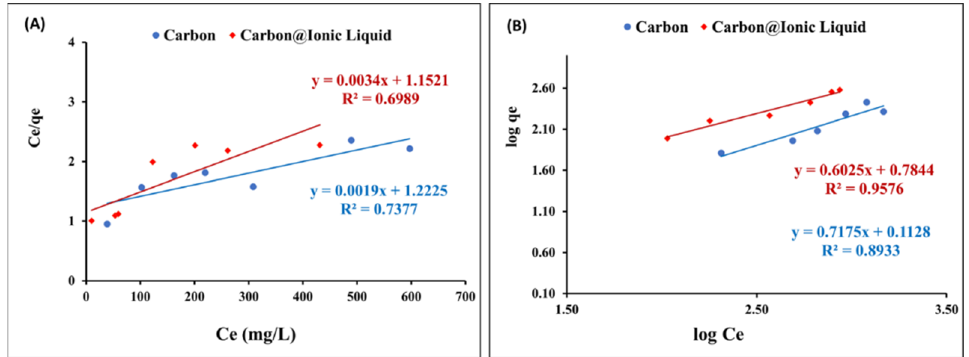
Figure 6. Equilibrium investigation for the adsorption of benzothiophene onto carbon and car-